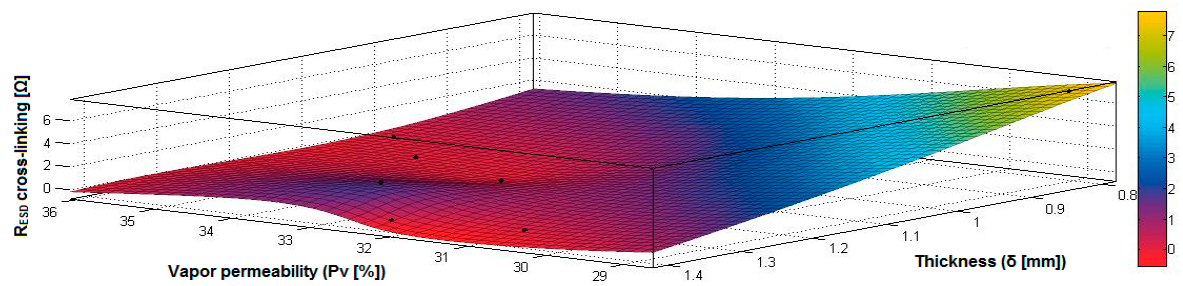
Figure 33. 3D representation R ESD after crosslinking = f(Pa, δ ) samples preliminarily treated in RF plasma O 2 using RF 2 generator and power 100 W.